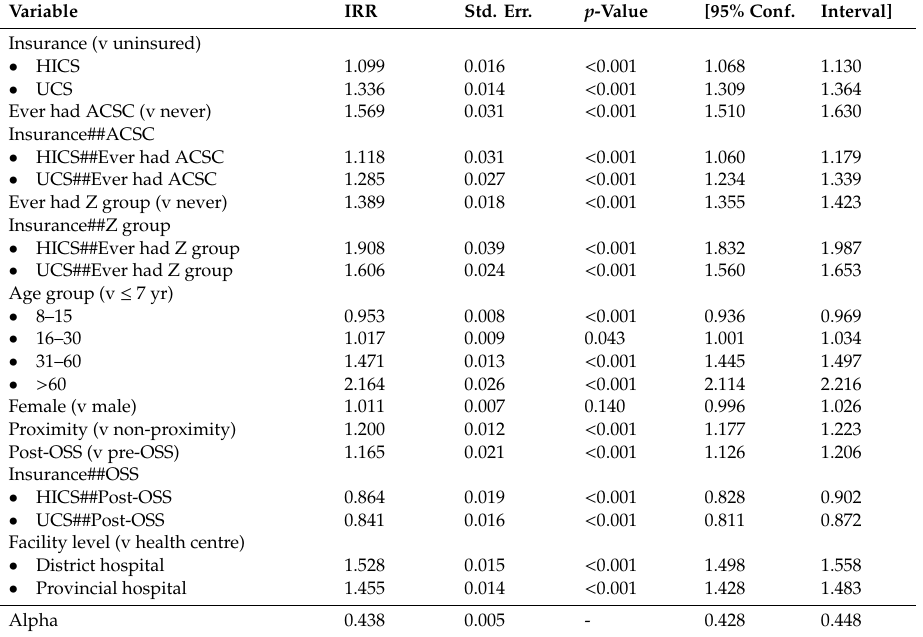
Table 4. Multivariable analysis of OP utilisation volume by the negative binomial regression with interaction terms. Variable IRR Std.